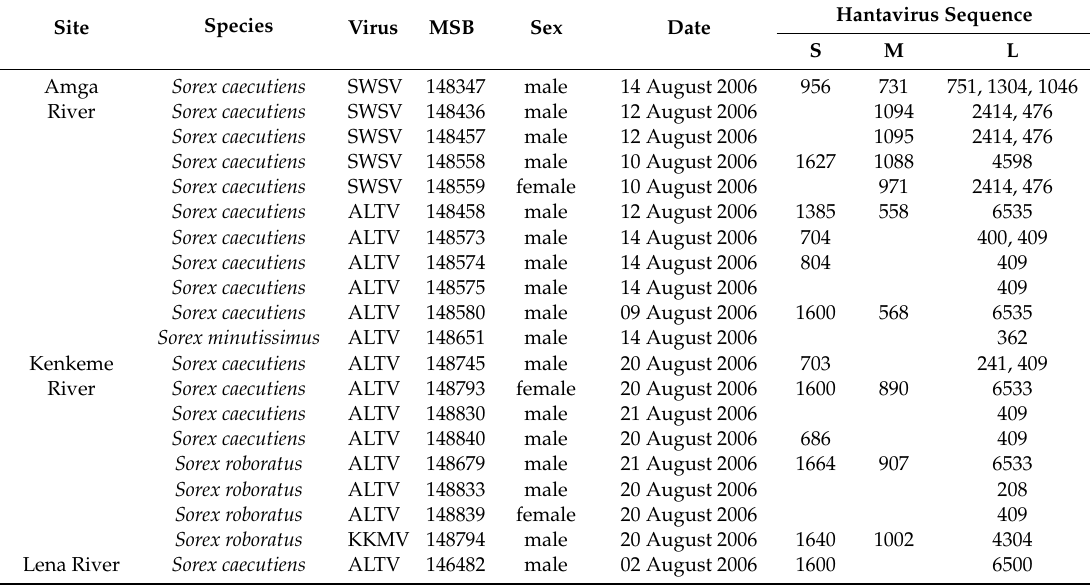
Table 2. Summary of hantavirus sequences in Sorex shrews captured in the Sakha Republic in 2006.